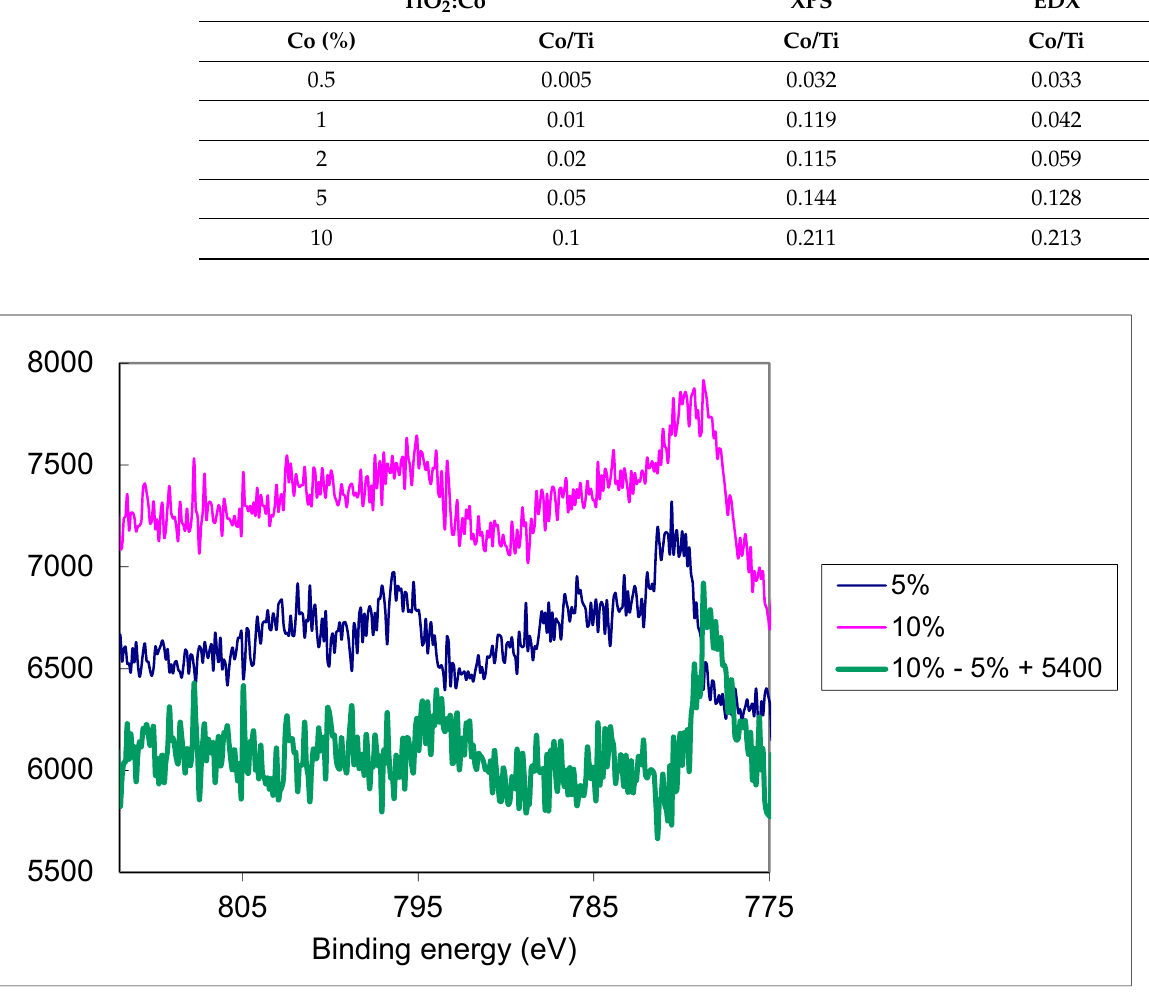
2 :0.05Co and TiO 2